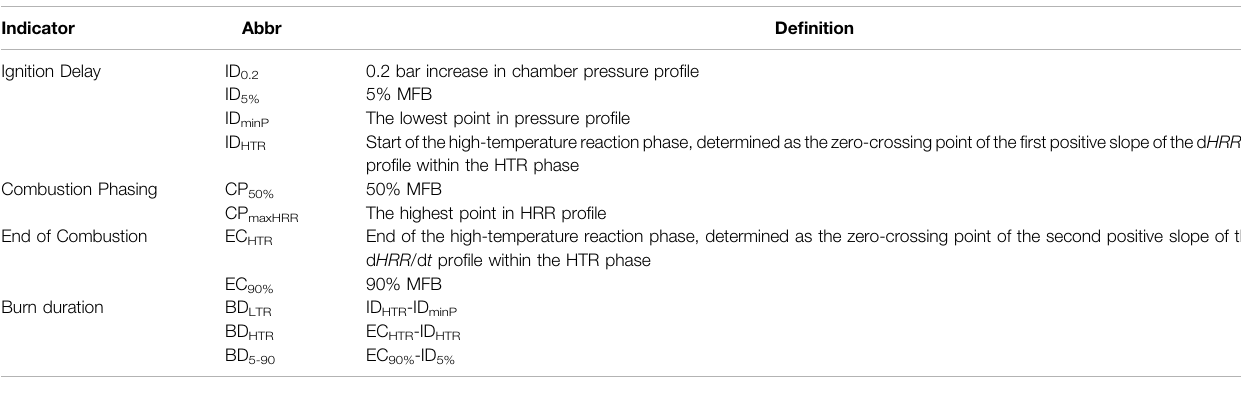
TABLE 4 | De fi nitions of indicators.